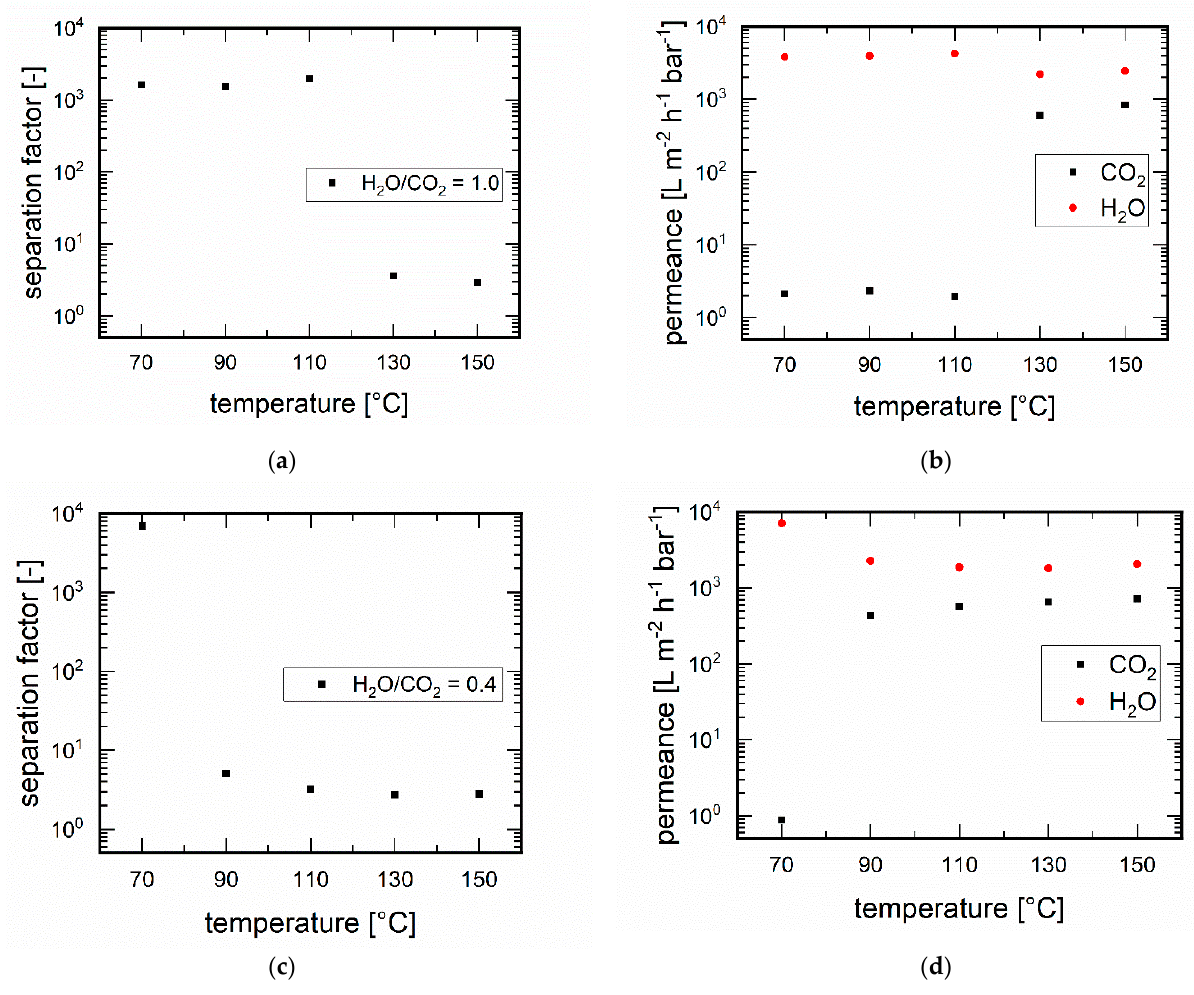
Figure 6. Temperature dependence of the separation at an H 2 O/CO 2 ratio of 1.0 the ( a ) separation factors and ( b ) perme- ances, and at an H 2 O/CO 2 ratio of 0.4 the ( c ) separation factors and ( d )